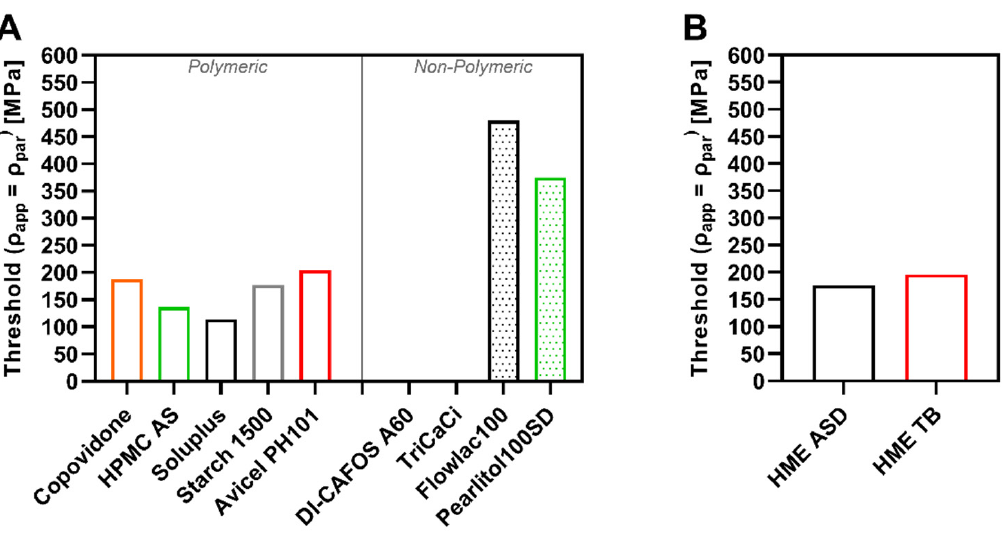
Figure 8. Particle density threshold in CP ( ρ app = ρ par ) of ( A ) polymeric and nonpolymeric excipients, and ( B ) of HME ASD and TB.